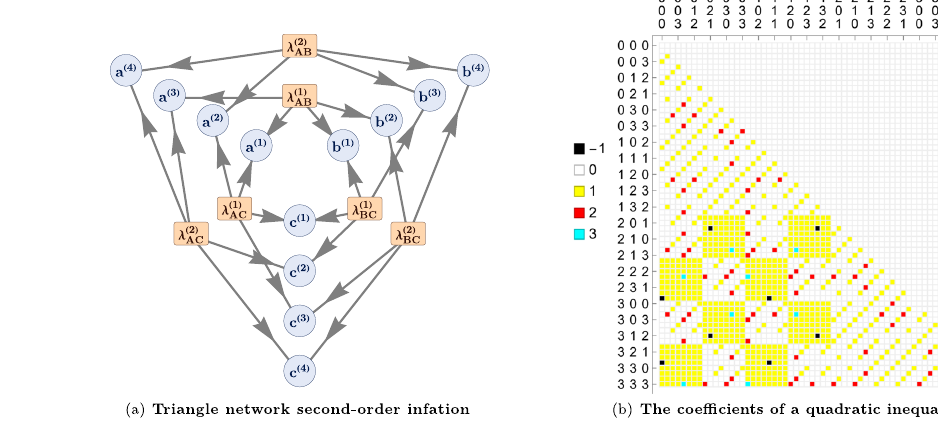
− 0.02436±0.00016 on our experimental data. The x -axis ranges exp = overthevaluesof(